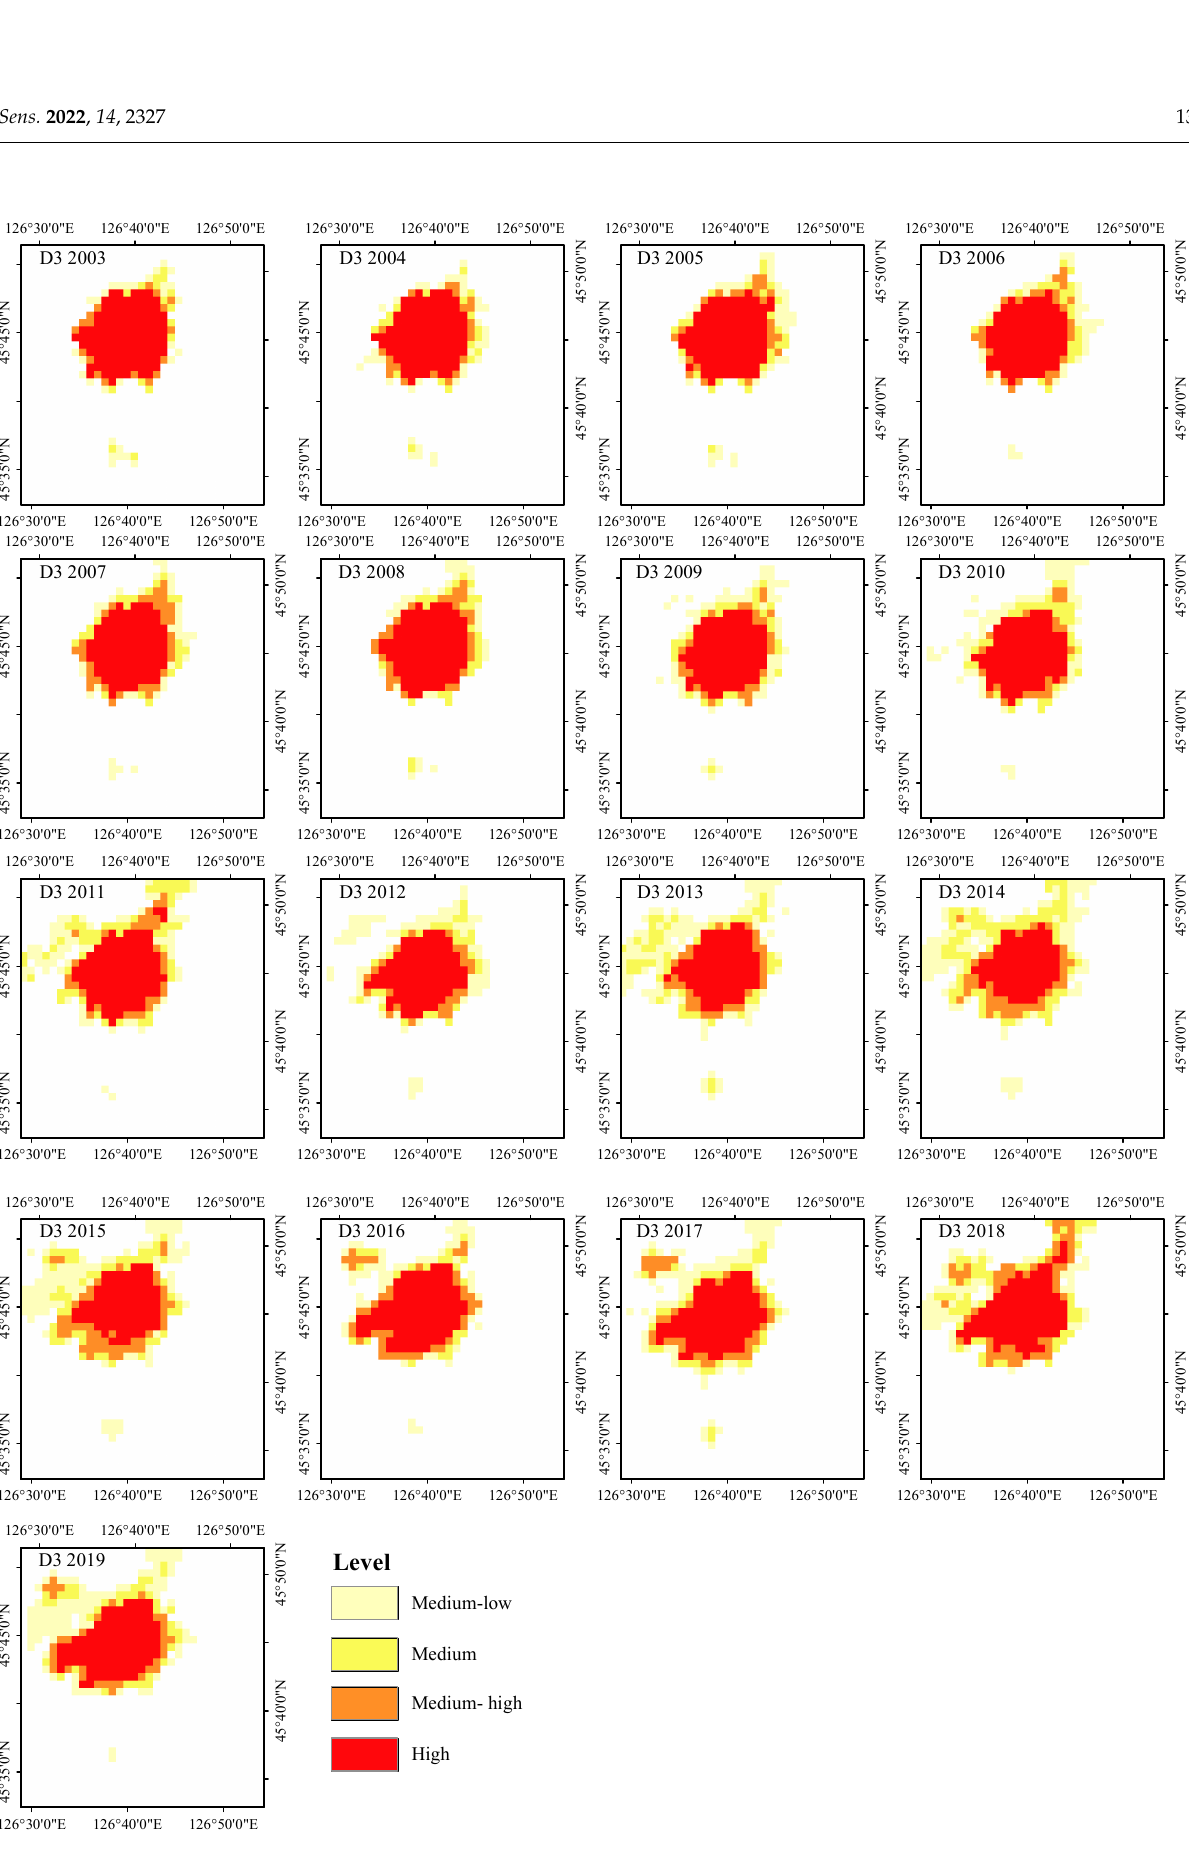
Figure 10. Equivalent heat island intensity (EHII) changes from 2003 to 2019 in D3.